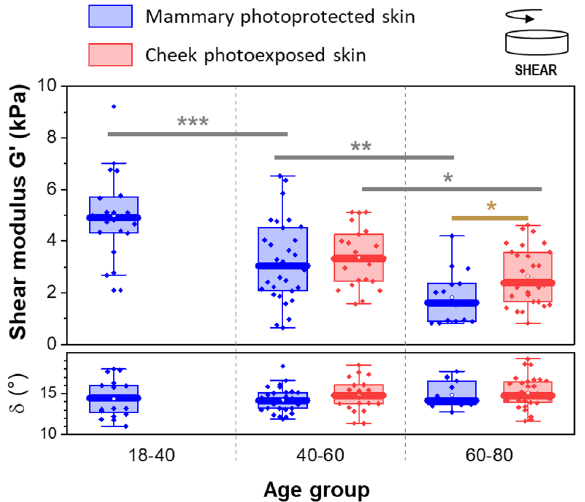
Figure 1. Storage modulus G ′ (upper panel) and Phase angle δ (lower panel) measured by shear deformation as a function of age group, for photoprotected mammary (blue) and photoexposed cheek (red) full-thickness skin. One dot represents one skin sample. Multiple samples were obtained for each donor. * p < 0.05, ** p < 0.01, *** p <